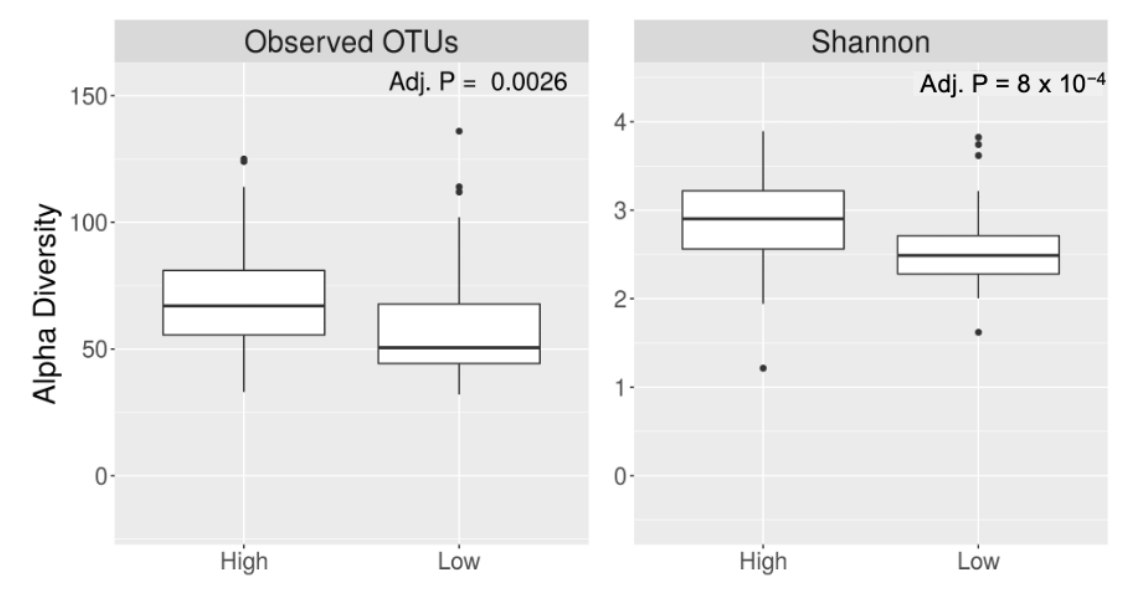
Figure 3. Beta diversity of gut microbiota based on daily intake of ( A ) caffeine and ( B ) coffee.